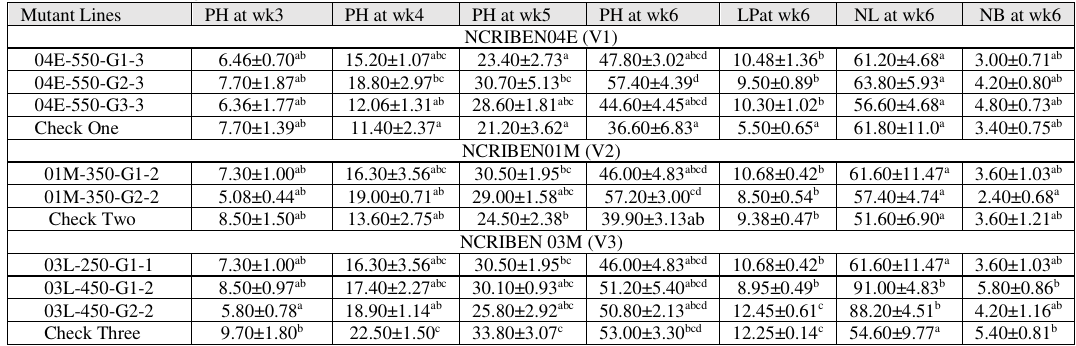
Table 2. Vegetative parameters of three varieties of sesame lines at different irradiation doses Mutant Lines PH at wk3 PH at